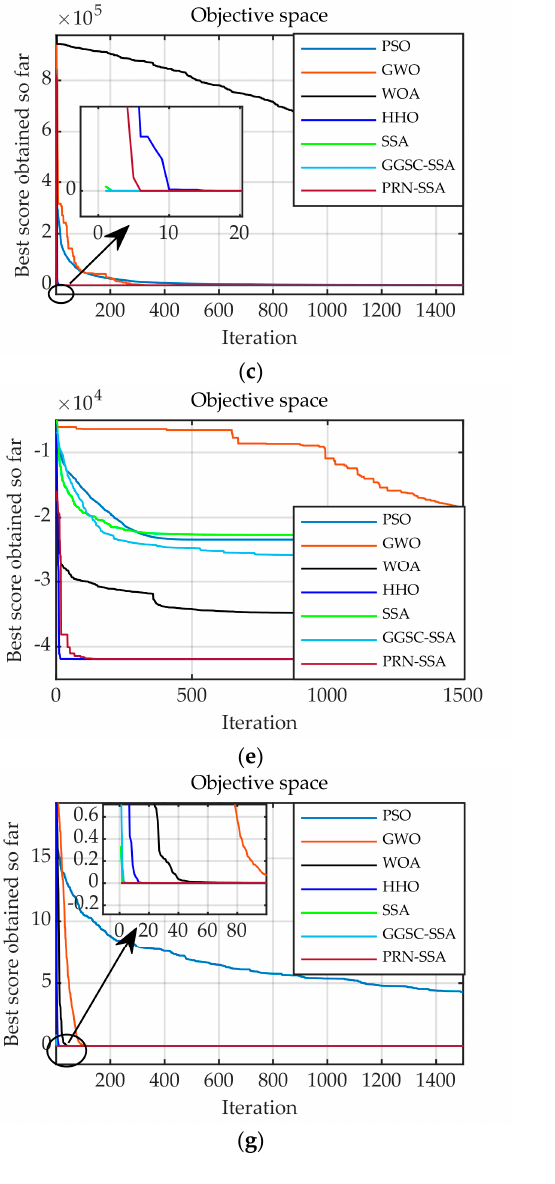
Figure 10. Optimization and convergence curves of each algorithm (100-dimension): ( a ) f 1 ; ( b ) f 2 ; ( c ) f 3 ; ( d ) f 4 ; ( e ) f 8 ; ( f ) f 9 ; ( g ) f 10 ; ( h ) f 11